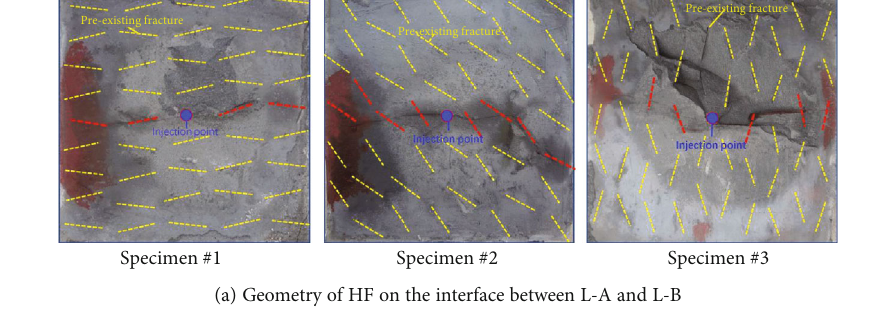
Stage (IV): pump stop stage. The HF propagates to the boundary of the specimen, and the injection pressure curve declines sharply